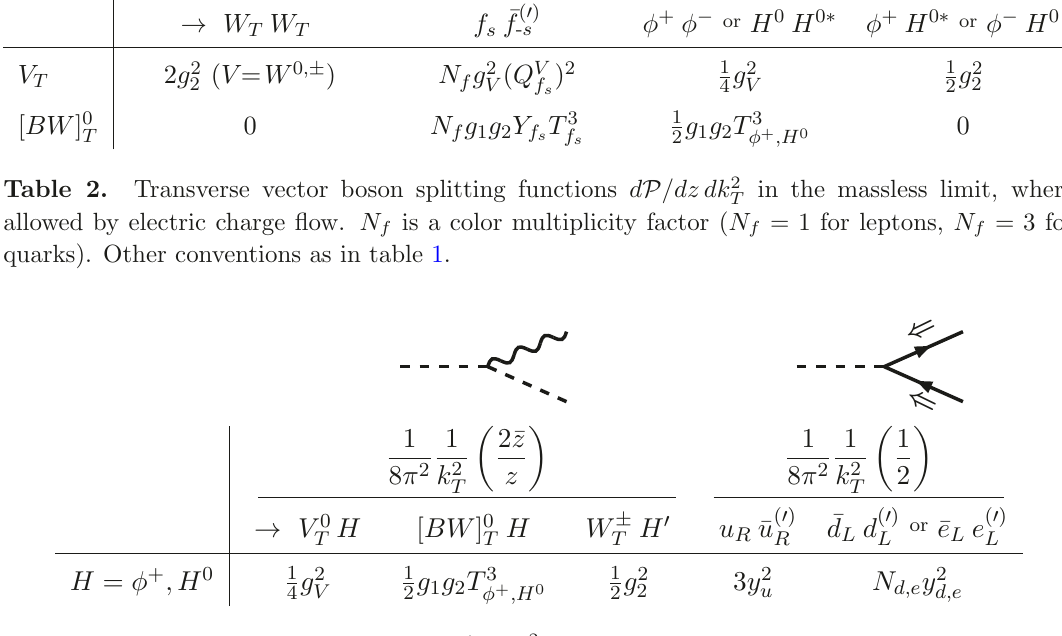
Scalar splitting functions d /dz dk 2 in the massless limit via gauge couplings and T P Yukawa couplings. The symbol H in the column headings represents the appropriate state φ + , H 0 for the given splitting, and H ′ represents the SU(2) L isospin partner (e.g., H 0 ′ = φ + ). Anti-particle splittings are obtained by CP conjugation. Other conventions as in tables 1 and